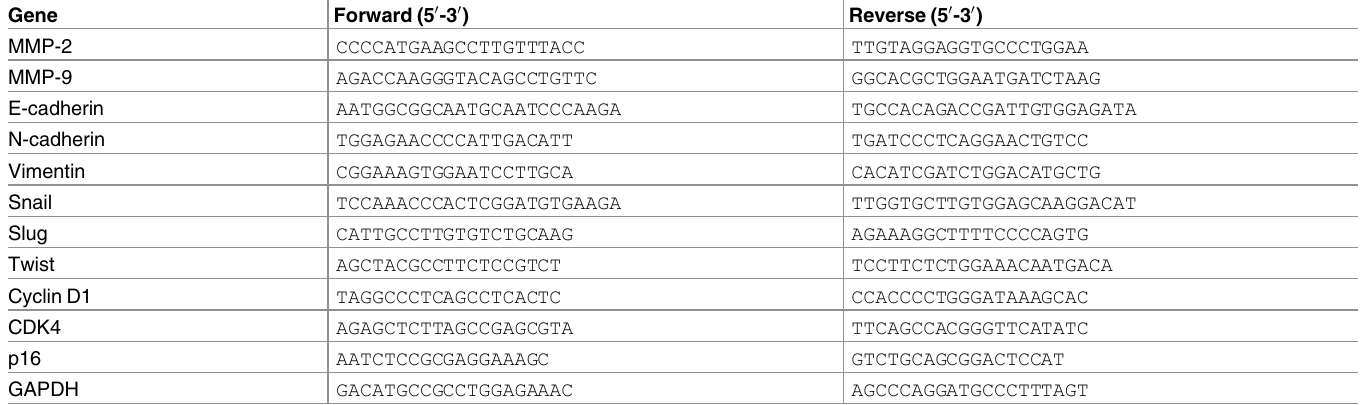
Table 1. Sequences of real-time RT-PCR